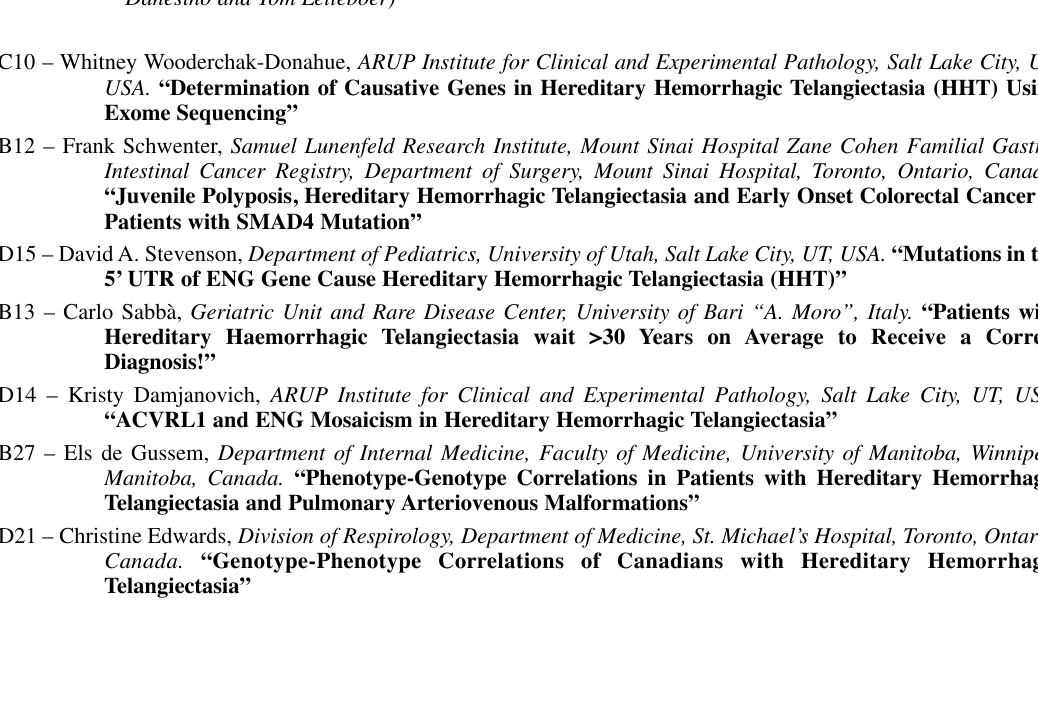
10:15-12:10 SESSION X: GENOTYPES, PHENOTYPES AND CORRELATIONS (Session chairs: